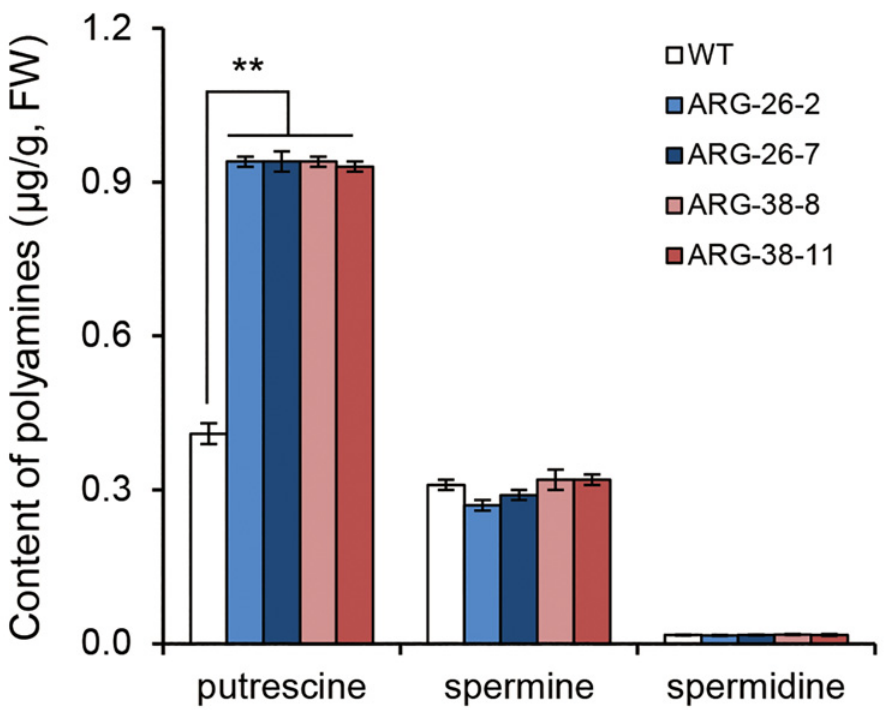
Fig 8. Comparison of the polyamine content in transgenic and control cotton plants grown under field conditions. The polyamine content here refers to the content of putrescine, spermine, and spermidine. All data in this figure are displayed as the mean values for putrescine, spermine, and spermidine content in the WT, ARG-26-2, ARG-26-7, ARG-38-8, and ARG-38-11 plants. The spermine and spermidine content in transgenic cotton plants were both imilar to those of the WT plants. The putrescine content in transgenic plants was two-fold greater than that in WT plants. ‘ FW ’ refers to fresh leaf weight. ‘ WT ’ refers to non- transgenic control plants of wild type cotton. ** : P <